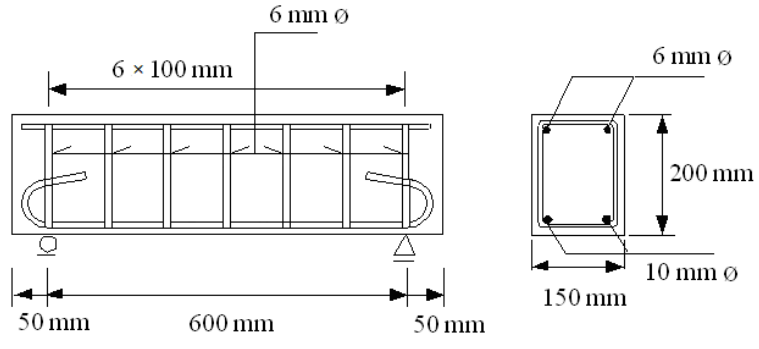
Figure 1. RC specimens’ details.